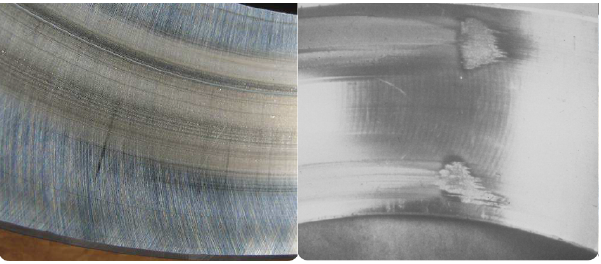
Figure 4. Wear failure. Abrasive wear ( left ) and adhesive wear ( right ) [27]. Courtesy of